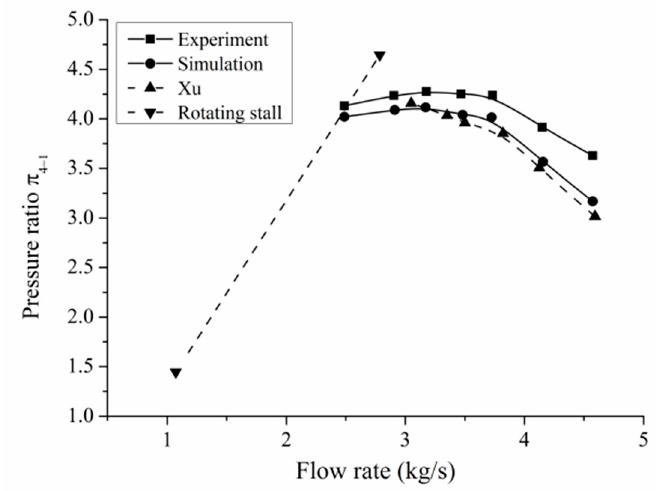
Figure 4. Experiment and simulation results of the Krain impeller [28].